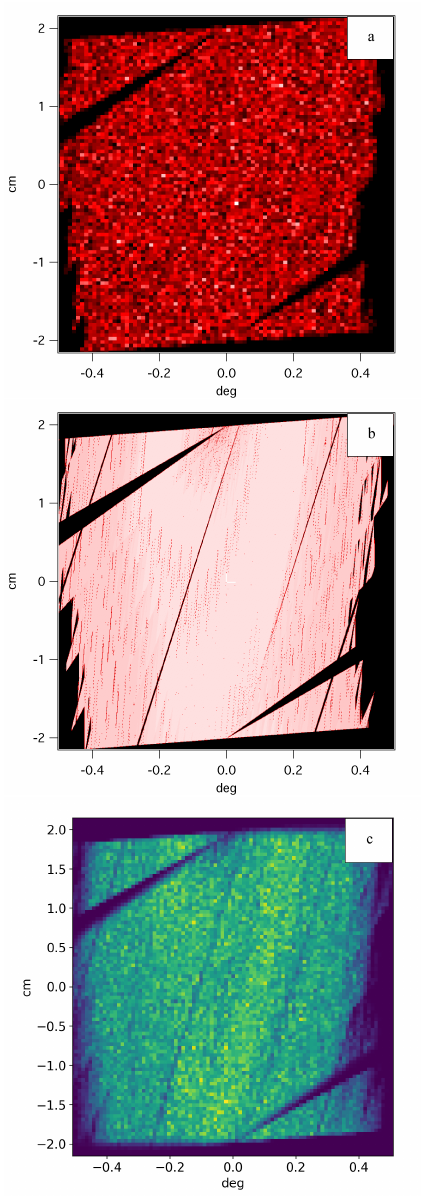
Figure 2. Simulation of the D22 instrument phase space at the attenuator position, computed with: ( a ) VITESS, from Reference [6]; ( b ) Acceptance Diagram Shading, from Reference [6]; ( c ) Sandman, the present